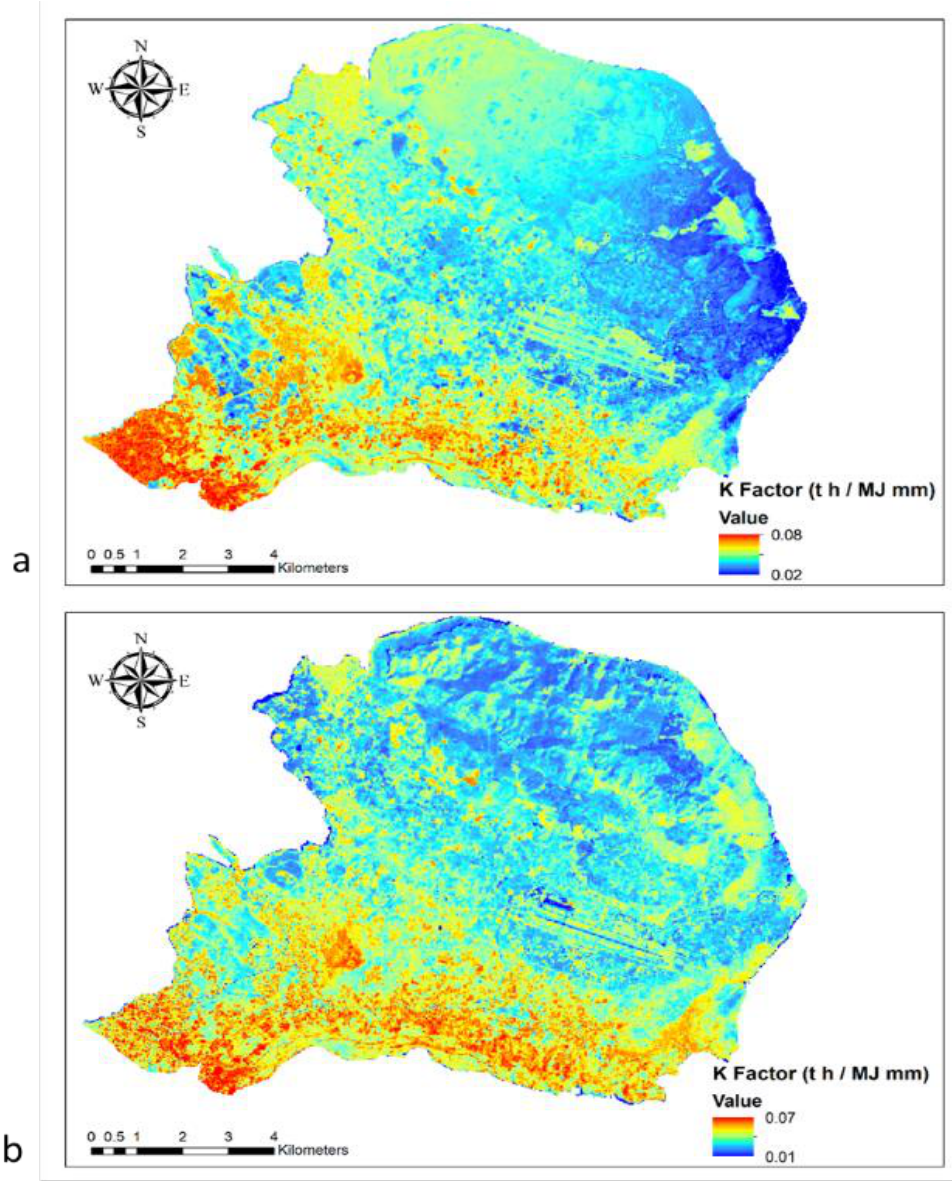
Figure 9. Spatial distribution of K-factor as estimated from the integrated use of ANN and (a) Landsat 8, and (b) Sentinel-2 imageries.